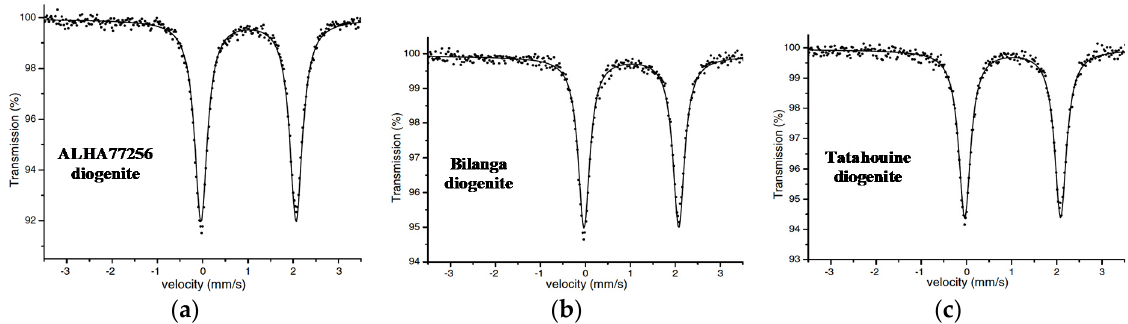
Figure 7. Comparison of the room temperature Mössbauer spectra of diogenites: ALHA77256 ( a ), Bilanga ( b ), and Tatahouine ( c ). Adapted from [21].